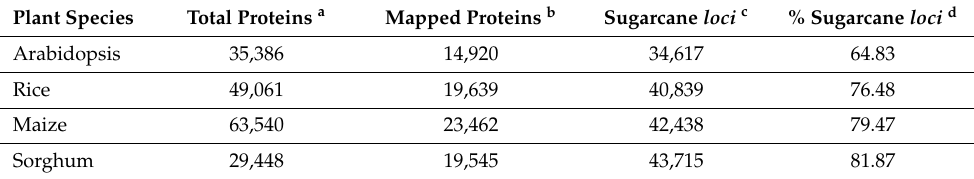
Table 1. Representation of sugarcane transcriptome in other plant databases. Sugarcane transcriptome loci were mapped against some plant species, and a high percentage of total proteins of these plants was